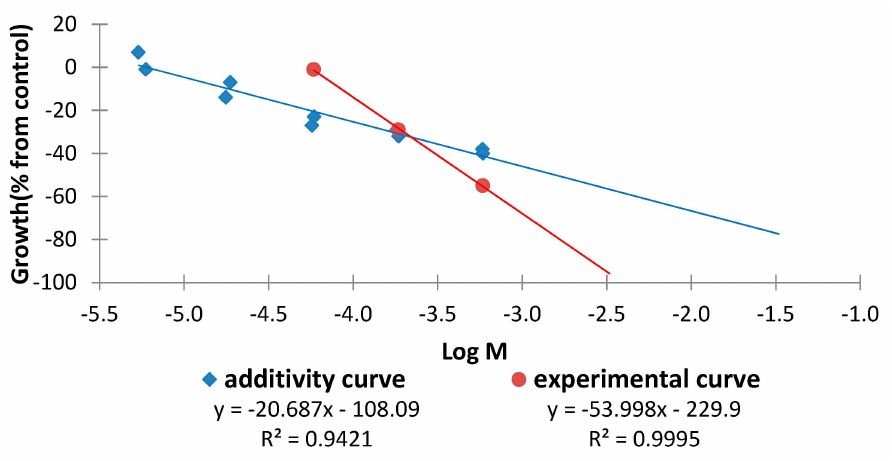
Figure 19. Comparison of the additive and experimental regression lines for the combination tetra- O -methylscutellarein ( 1 )/6,7,8,3 1 ,4 1 -pentamethoxyflavone ( 2 ) in a 1:9